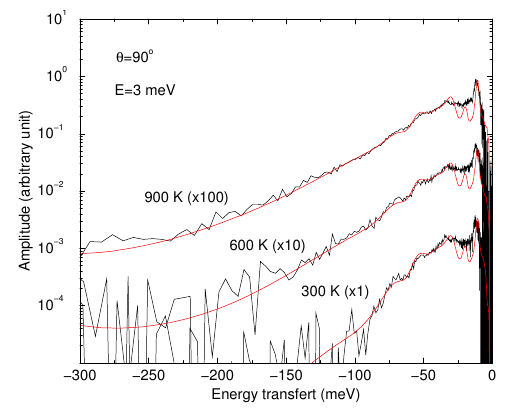
Figure 1. (Color online) Simplified top view of the IN6 time-of- flight spectrometer of the Intitute Laue-Langevin (ILL).